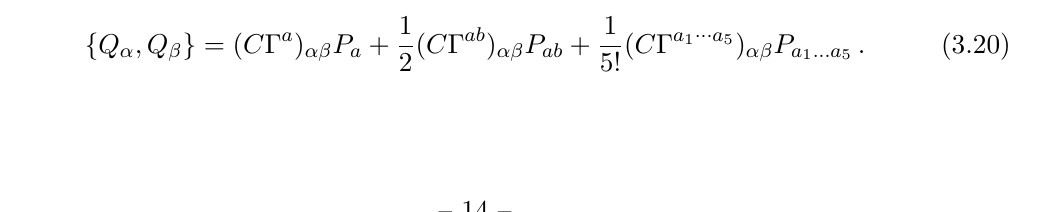
Dynkin diagram. 5